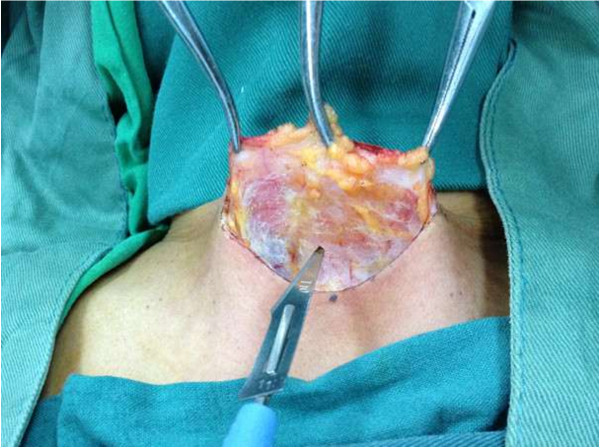
Develop subplatysmal flaps with high frequency electric knife.